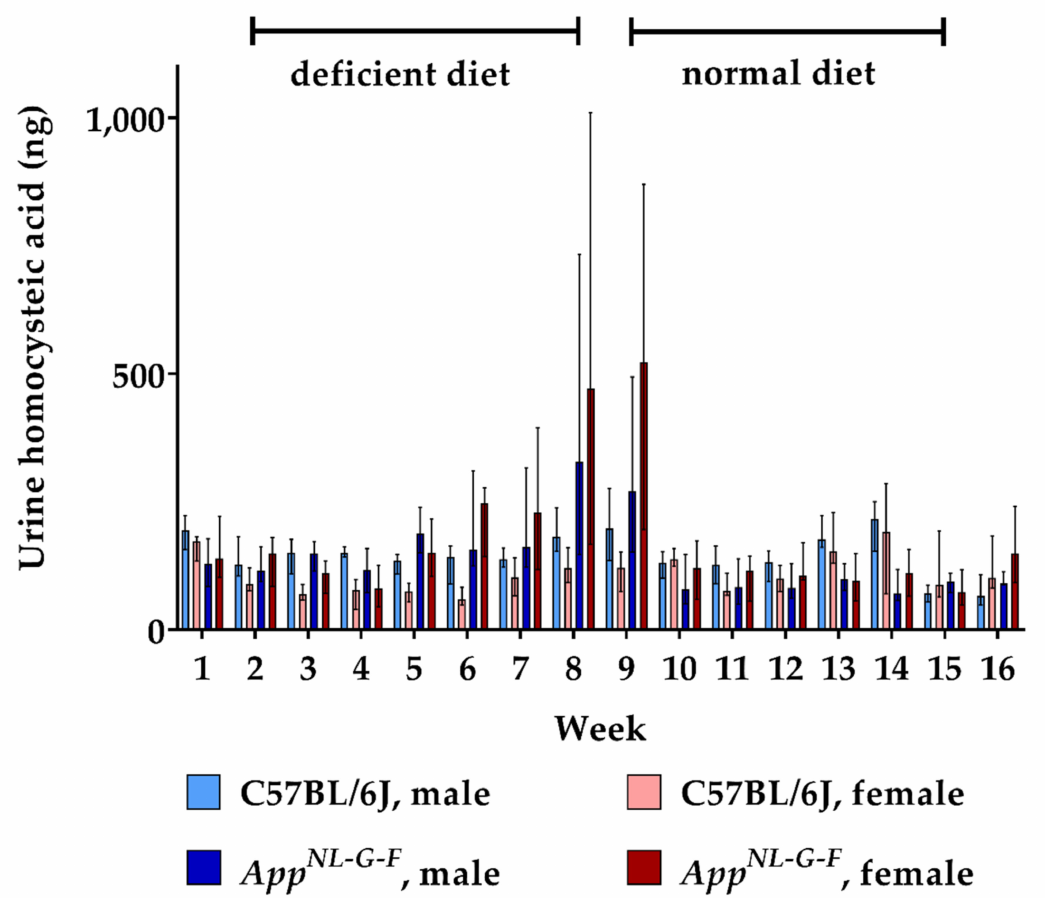
Figure 4. Urinary homocysteic acid levels in C57BL/6J wild type and App NL-G-F knock-in mice, data are depicted for males and females separately for experimental week 1–17: baseline measurement (w. 1), diet deficient in vitamin B6, B12 and folate (for 8 w.), balanced normal chow (for 8 w.); all urine samples were analyzed using a combination of liquid chromatography with tandem mass spectrometry and statistically tested non-parametrically using the Kruskal-Wallis test; data are presented as median ± interquartile range (IQR); extreme outliers beyond 3xIQR have been